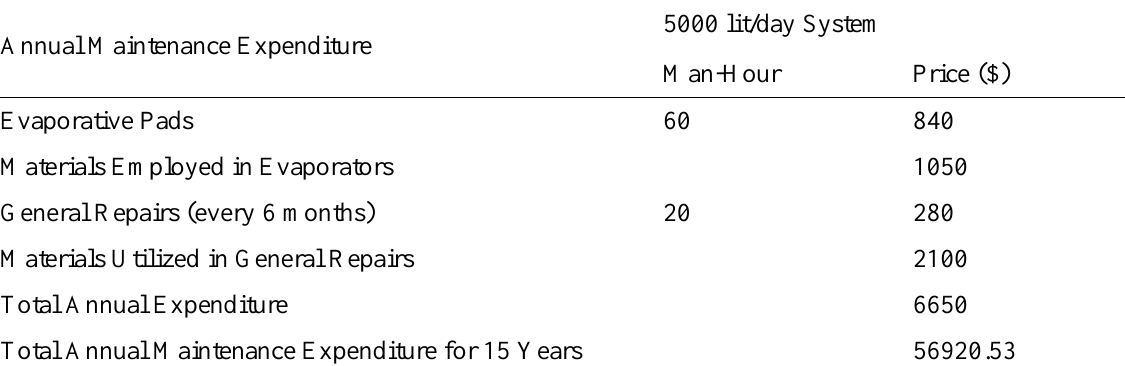
Table 7. Annual Maintenance Expenditure for MEH